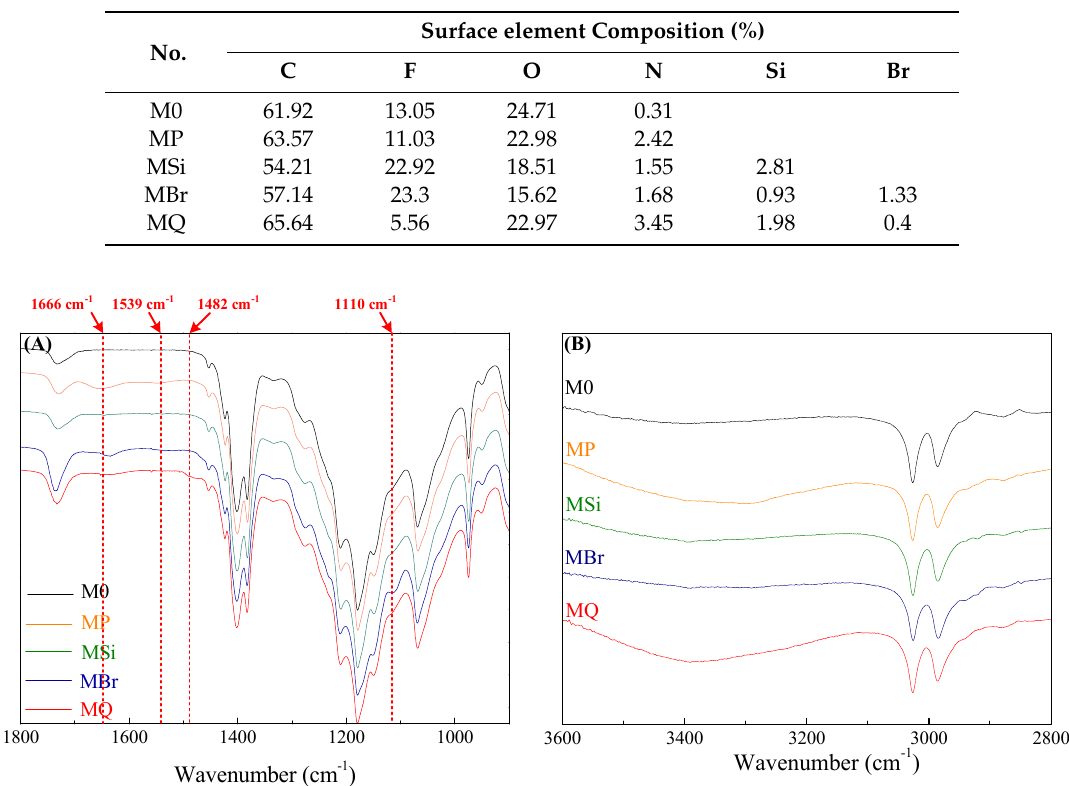
Table 2. Membrane surface compositions analyzed by XPS.